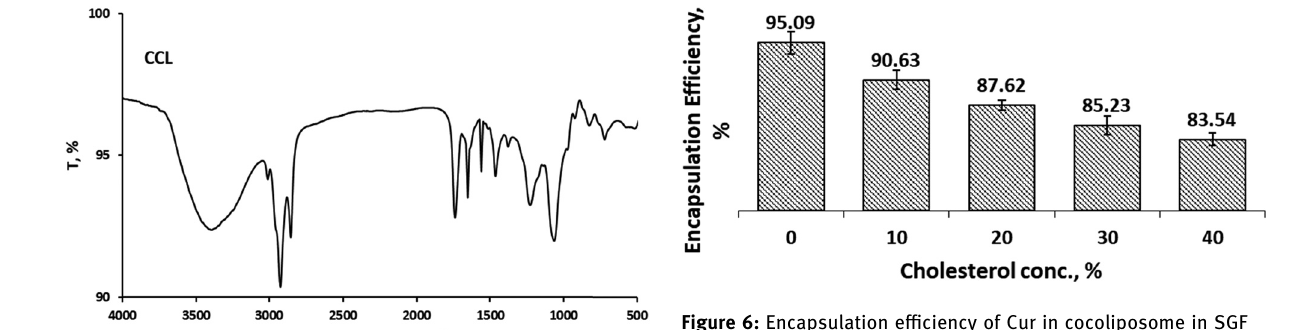
Figure 6: Encapsulation e ffi ciency of Cur in cocoliposome in SGF solution as a function of cholesterol.